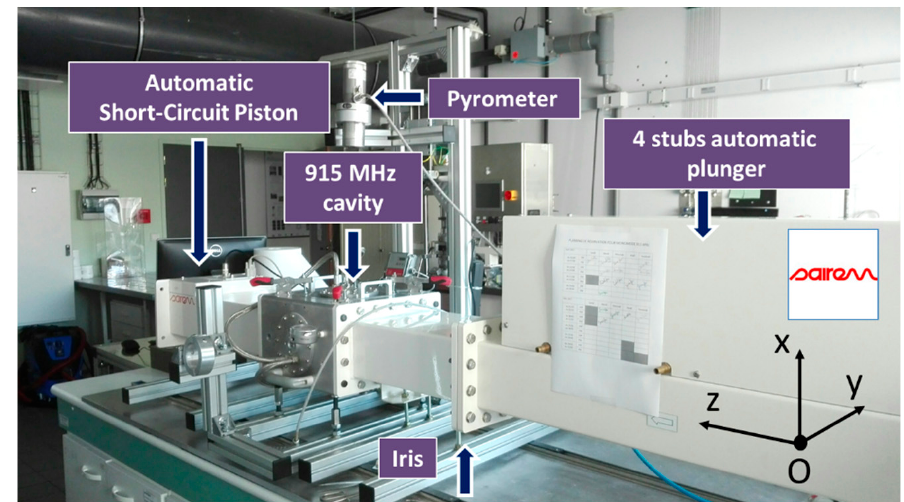
Figure 1. Photograph of the microwave system with the four-stub automatic impedance tuning device and the short-circuit piston.